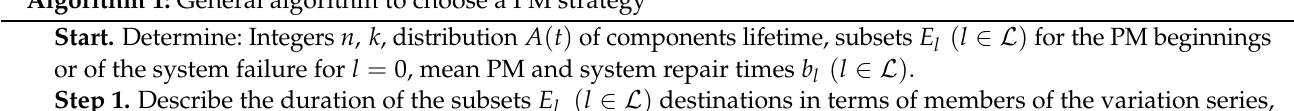
Algorithm 1: General algorithm to choose a PM